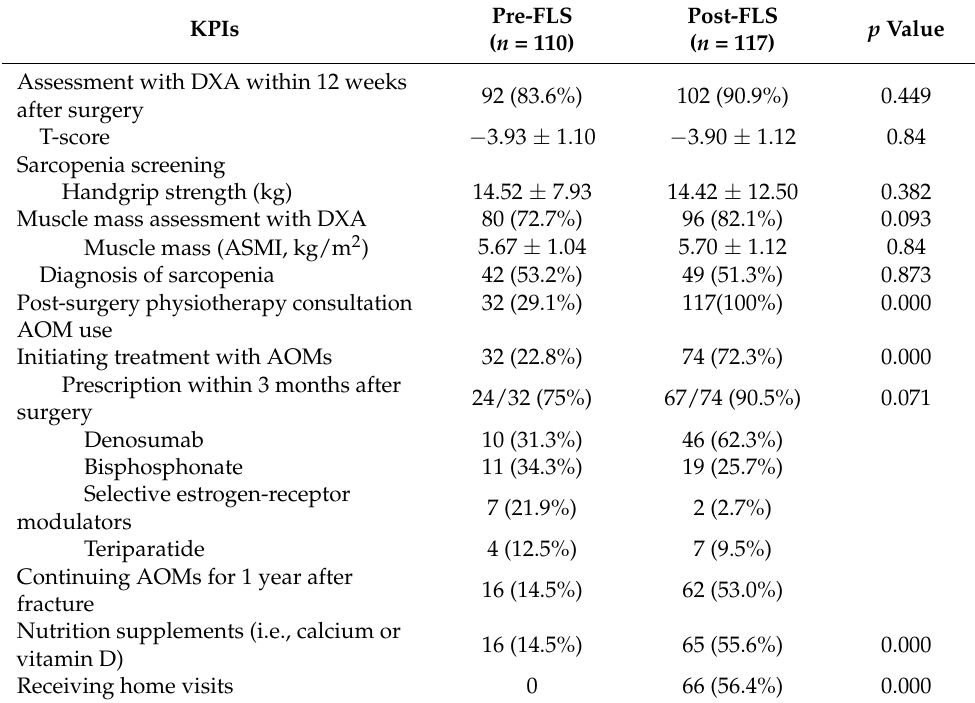
Table 2. Comparison of KPIs between the pre-FLS and post-FLS